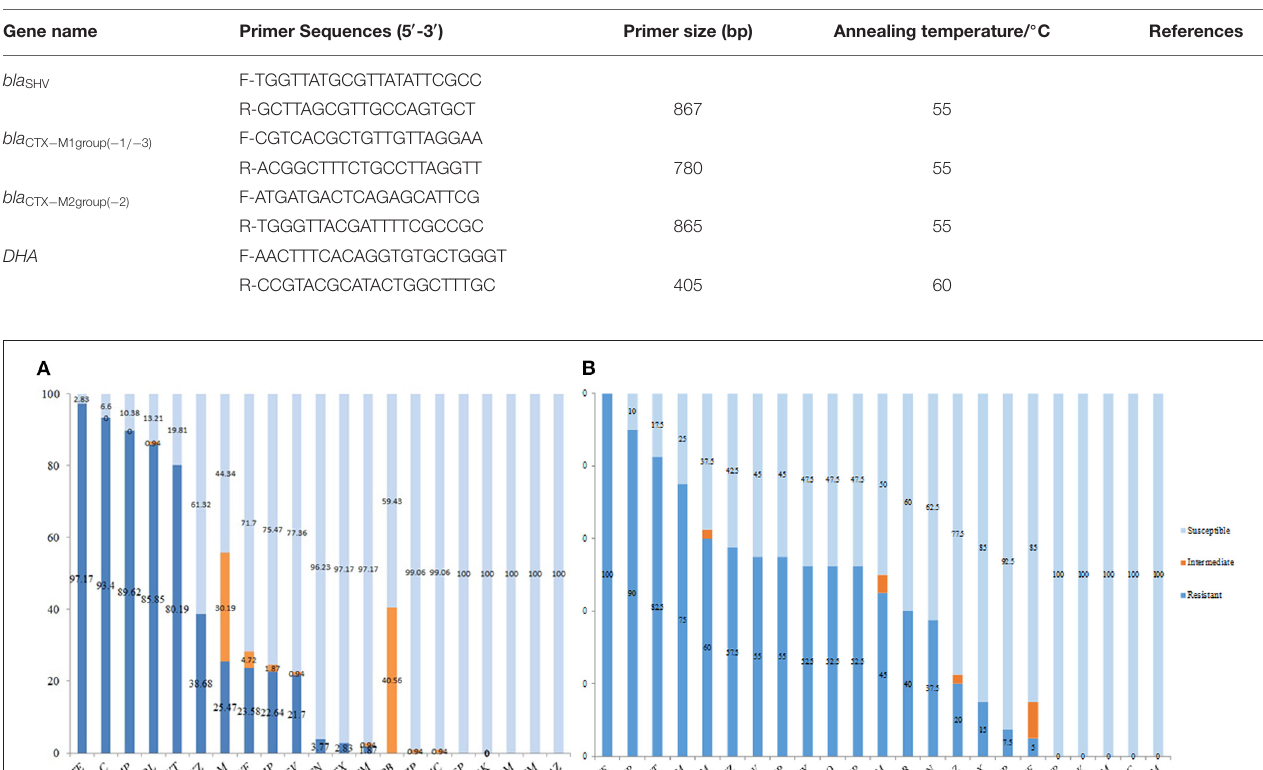
ATM + LEV + TE being the most popular drug-resistant one ( Supplementary Table 5